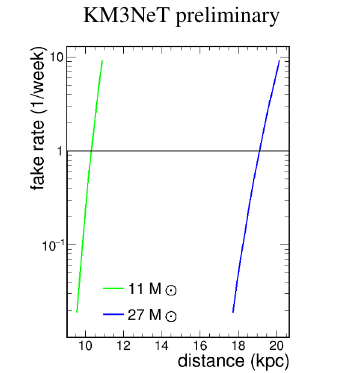
Figure 3. Fake trigger rate in ORCA as a function of the distance to the CCSN for the two progenitors studied. The black line in- dicates the SNEWS threshold.